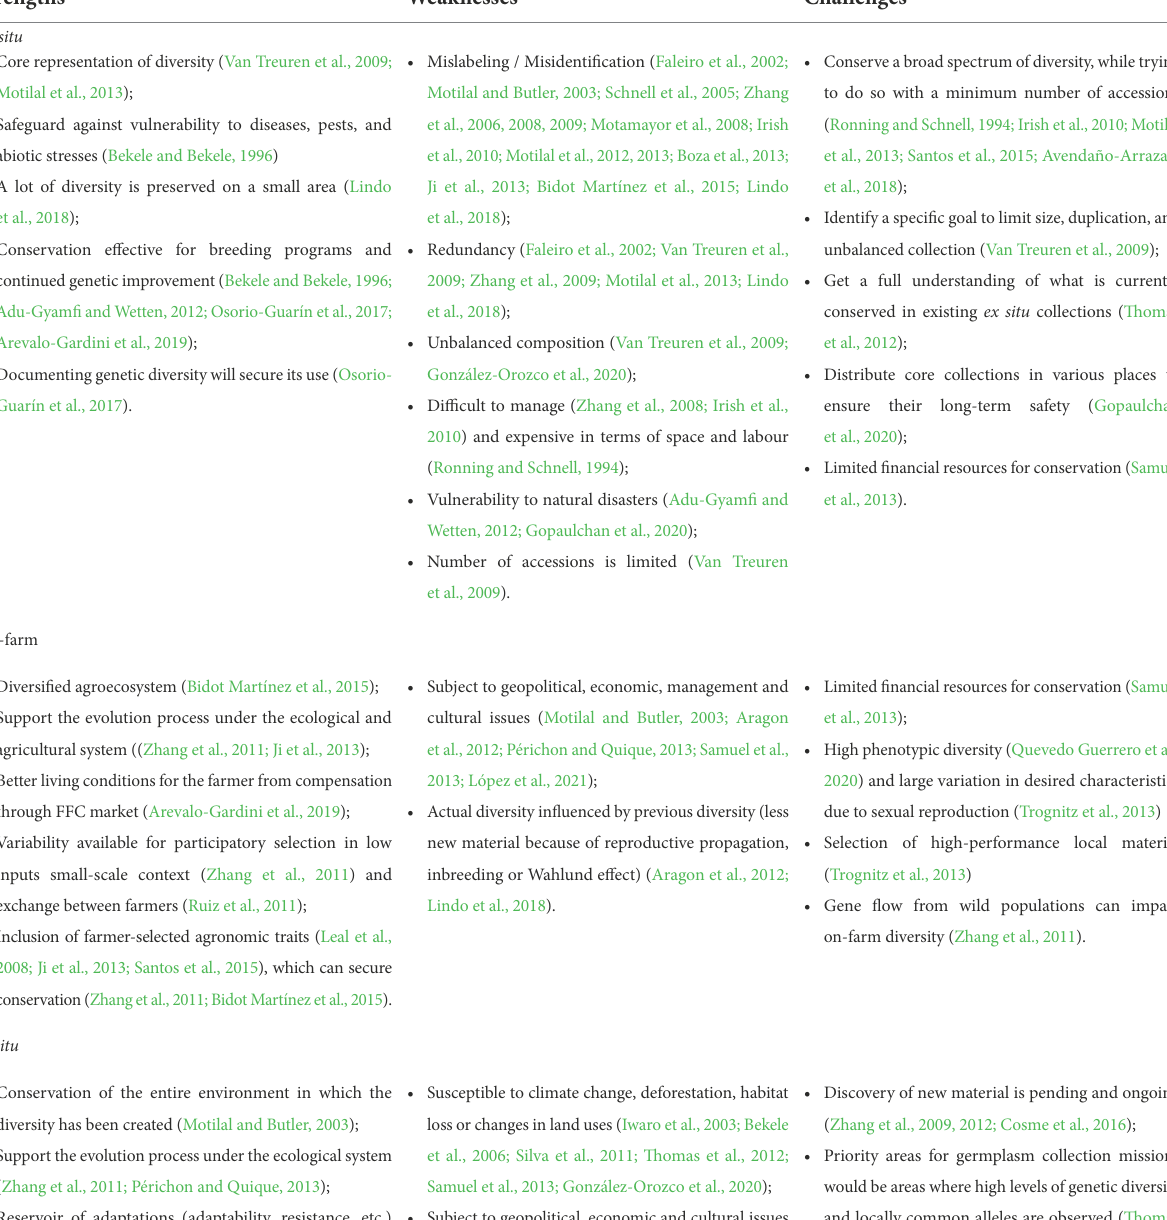
TABLE 1 Strengths, weaknesses, and challenges of ex situ , on-farm and in situ conservation in the 70 articles analyzed.